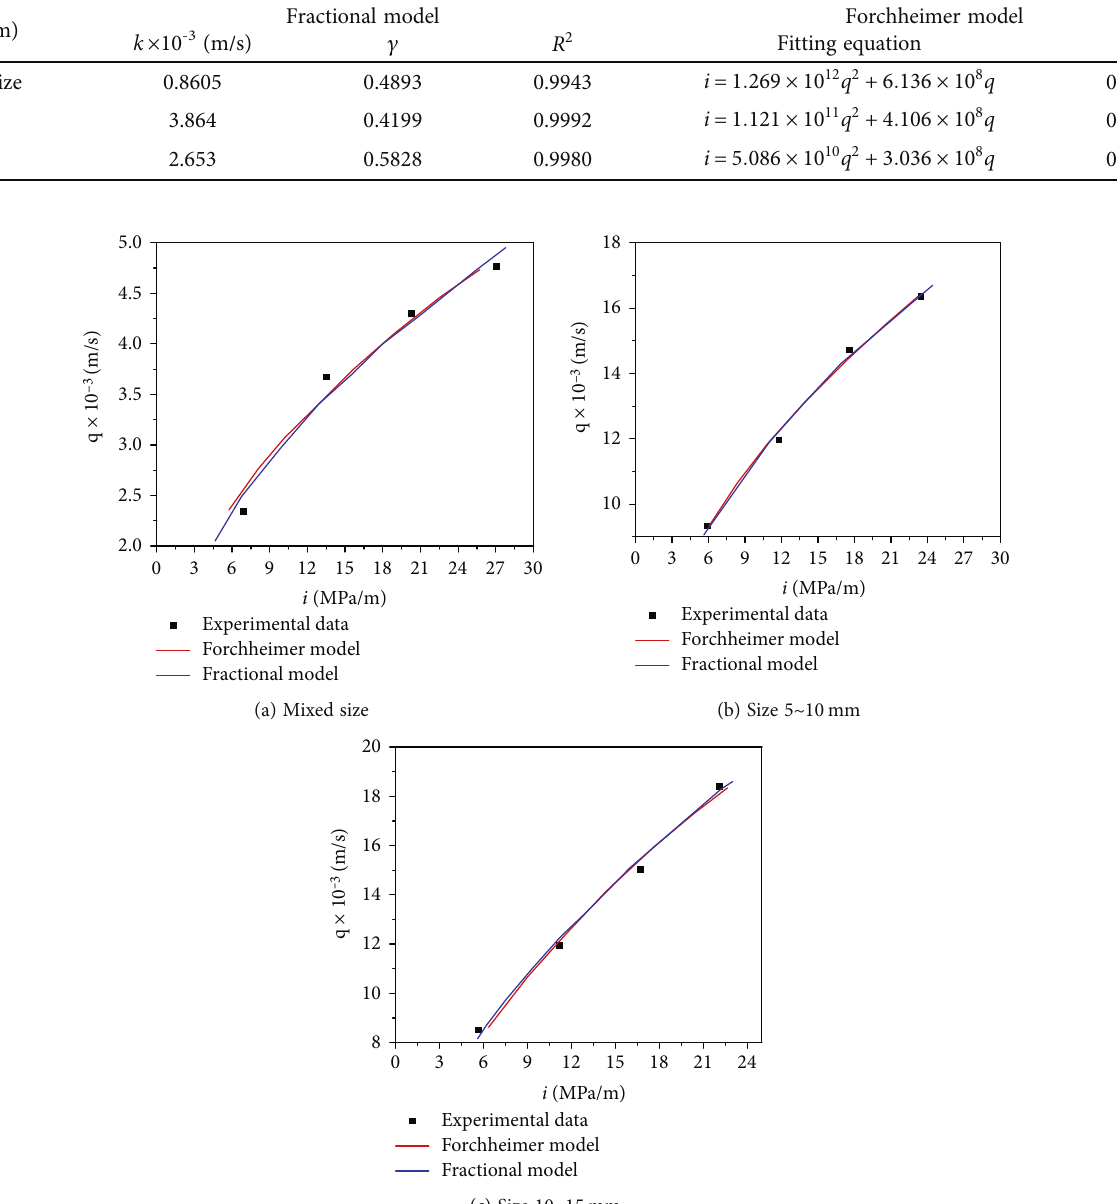
Figure 12: Fitting curves given by fractional non-Darcian model.